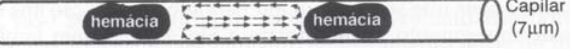
Fig.1 - Fluxo em leito capilar. Representação de fluxo não laminar em leito capilar onde a hemácia converte-se num êmbolo